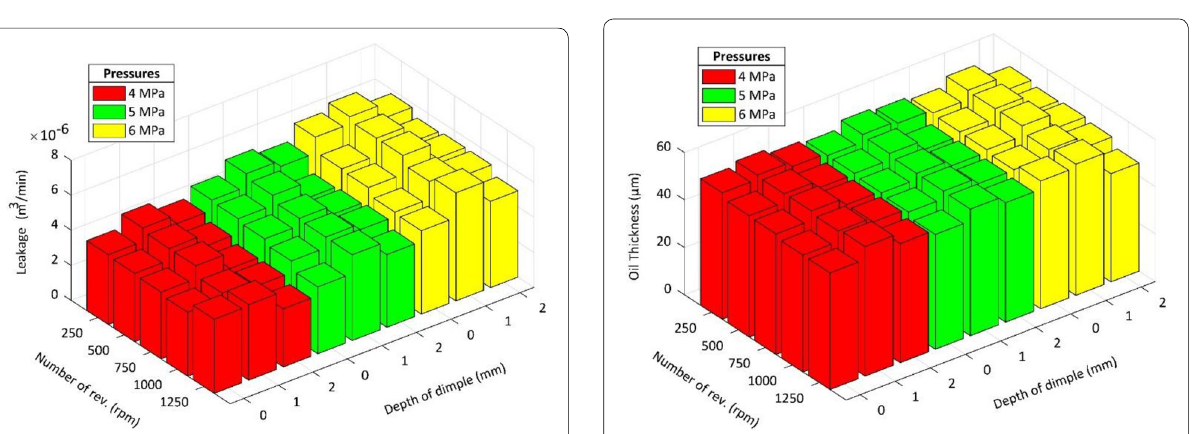
Figure 8 Oil film thickness under different study parameters for different dimple